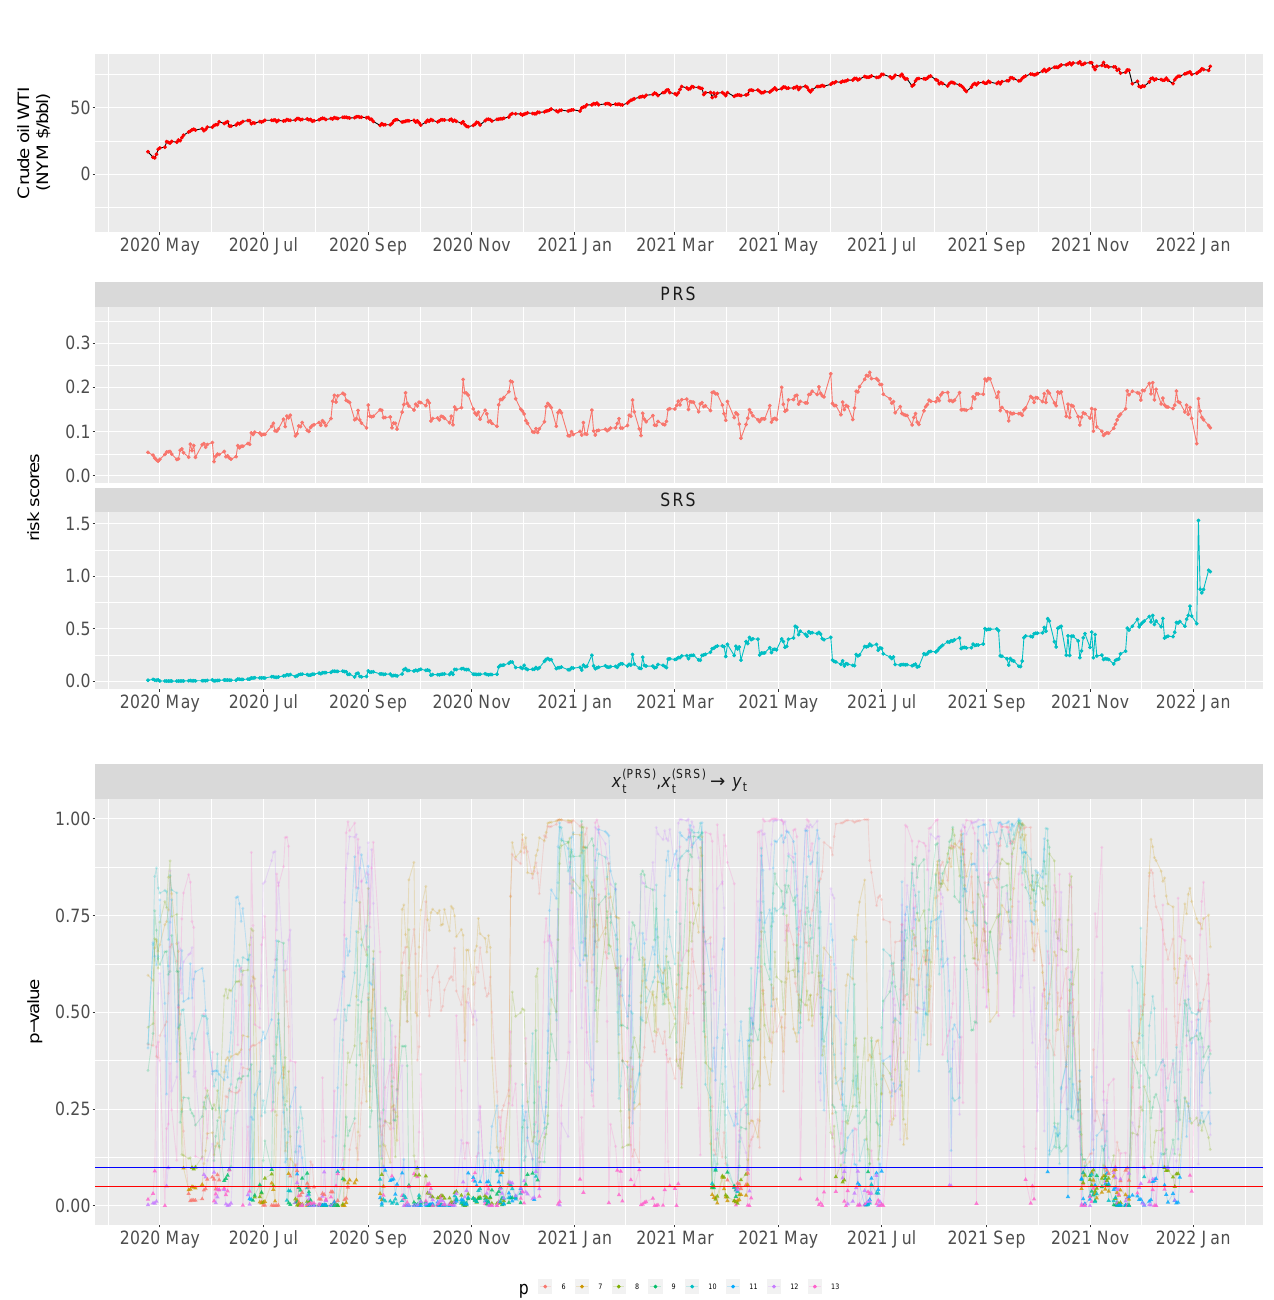
Figure 3. Time series plot of p -values (PRS and SRS; window width= 56; with different time lag p = { 6,7, . . . ,13 }